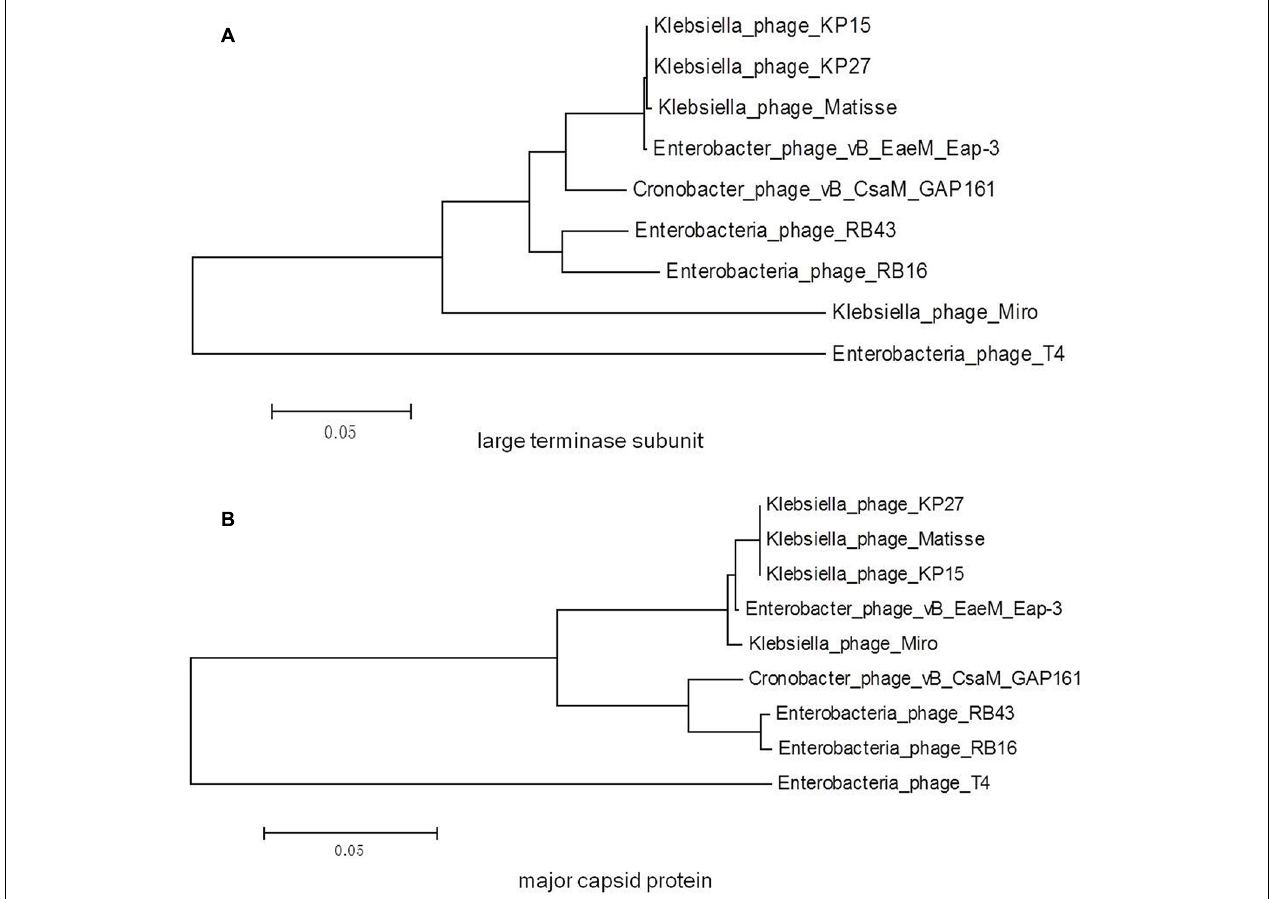
FIGURE 8 | Phylogenetic trees generated based on the (A) large terminase subunit and (B) major capsid proteins of vB_EaeM_ ϕ Eap-3 and homolog proteins from other members of the Tevenvirinae subfamily. Amino acid sequences were compared using ClustalW, and phylogenetic trees were generated using the neighbor-joining